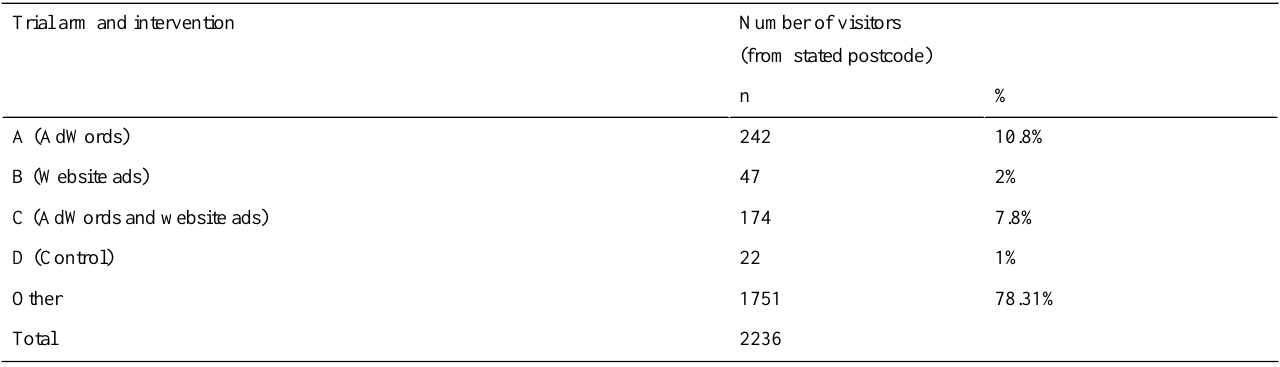
Table 3. Website data showing total visitors (n = 2236) between June 9 and September 30 (from all sources), classified using the postcode area they gave into an arm in the trial or as other area (ie, not in the trial).